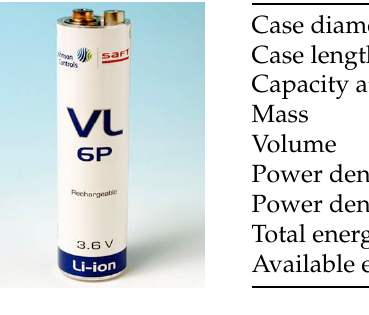
Figure 2. The VL6P lithium-ion cell and its specification